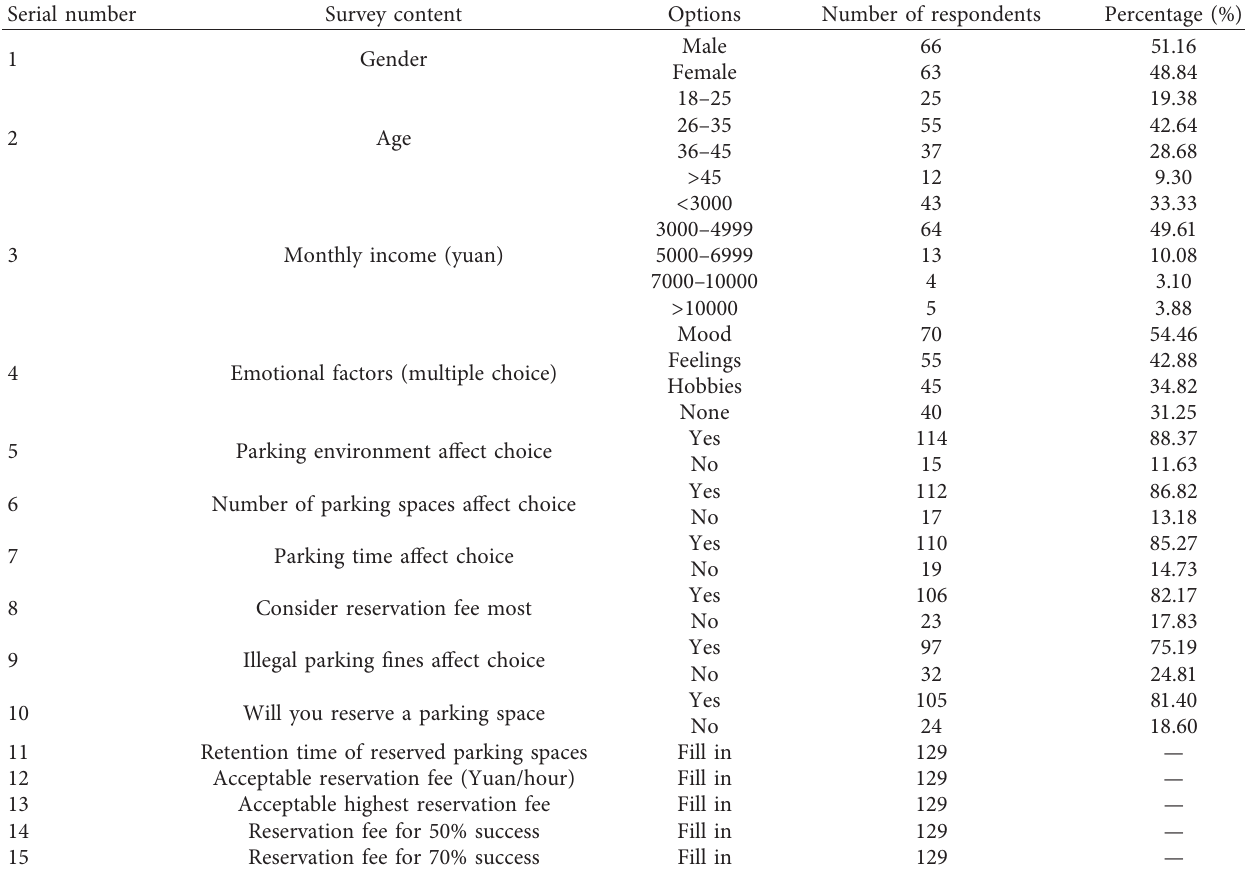
Table 1: Survey statistics of the respondents’ personal characteristics and choice